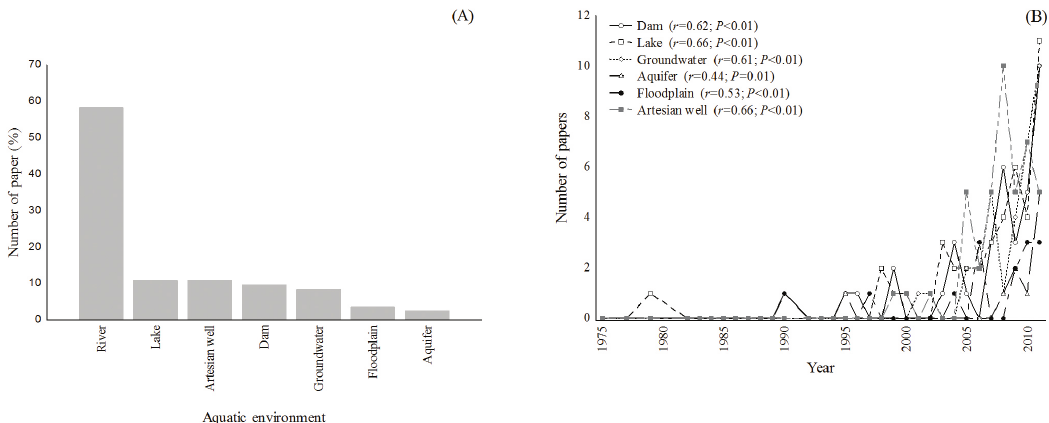
Figure 2. Aquatic environment studied (A), and temporal trend in number of paper for each aquatic environment